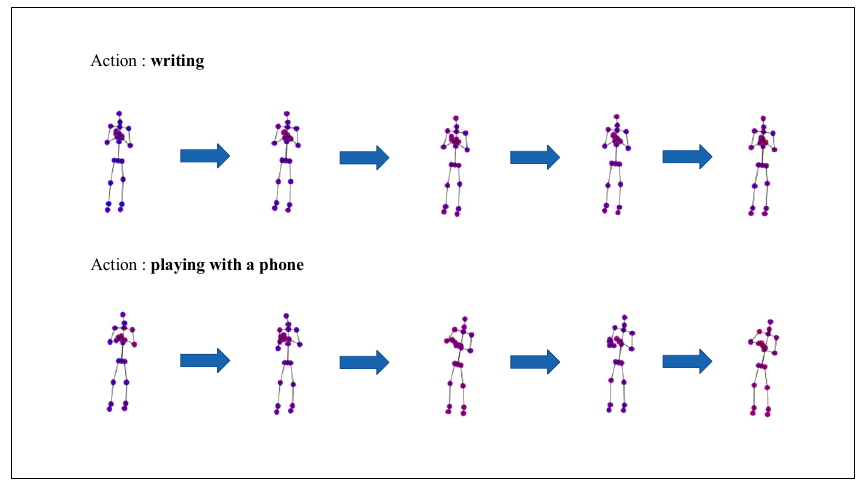
Figure 5. Visualization of the two actions of writing and playing with a phone. For each action, we selected five key frames to represent.